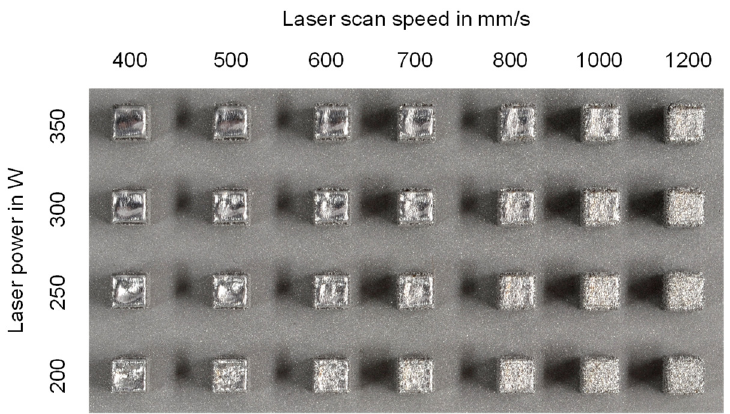
Figure 5. Examples of as ‐ built cubes in the function of laser power and laser scan speed (Top view, part dimension: 4 × 4 × 5 mm 3 , alloy: X2CrNiMoN25 ‐ 7 ‐ 4). part dimension: 4 × 4 × 5 mm 3 , alloy: